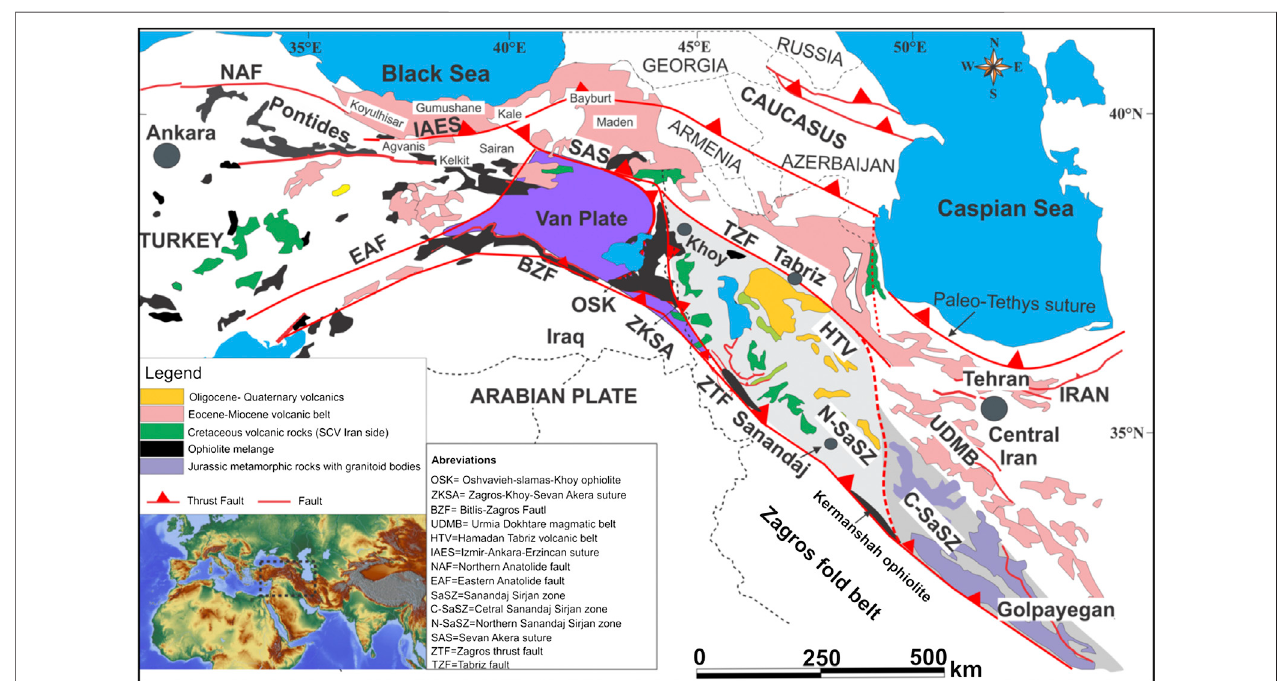
FIGURE2| Distribution ofthemainsuture zones andmagmaticrocks fromtheCretaceoustoQuaternaryinTurkeyand northwesternIranwiththeVan-microplate position. Ophiolite members are distributed in the main suture zones that surround the Van microplate (modi fi ed from Nouri et al., 2016).